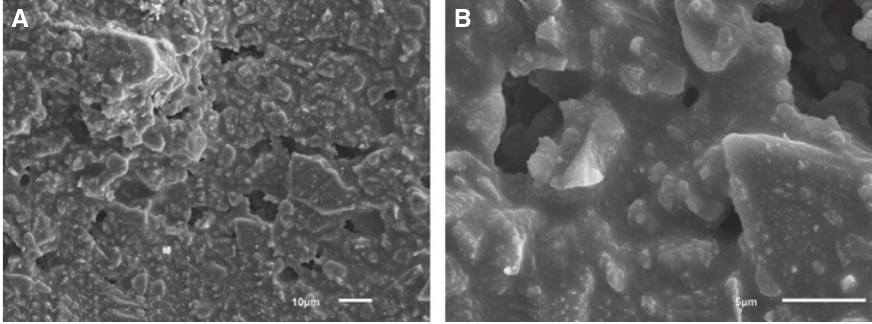
Figure 14: Surface morphology of E600 taken at different magnifications (A) × 1000 and (B) × 5000.